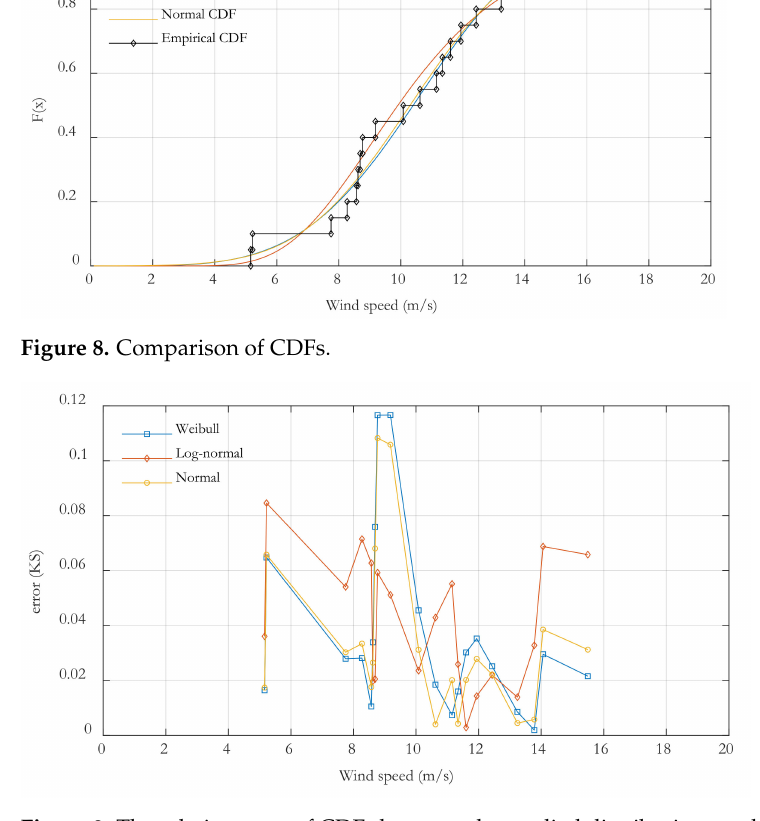
Figure 9. The relative error of CDFs between the applied distributions and actual distribution. Table 6. Comparison of three distributions in terms of goodness-of fit test